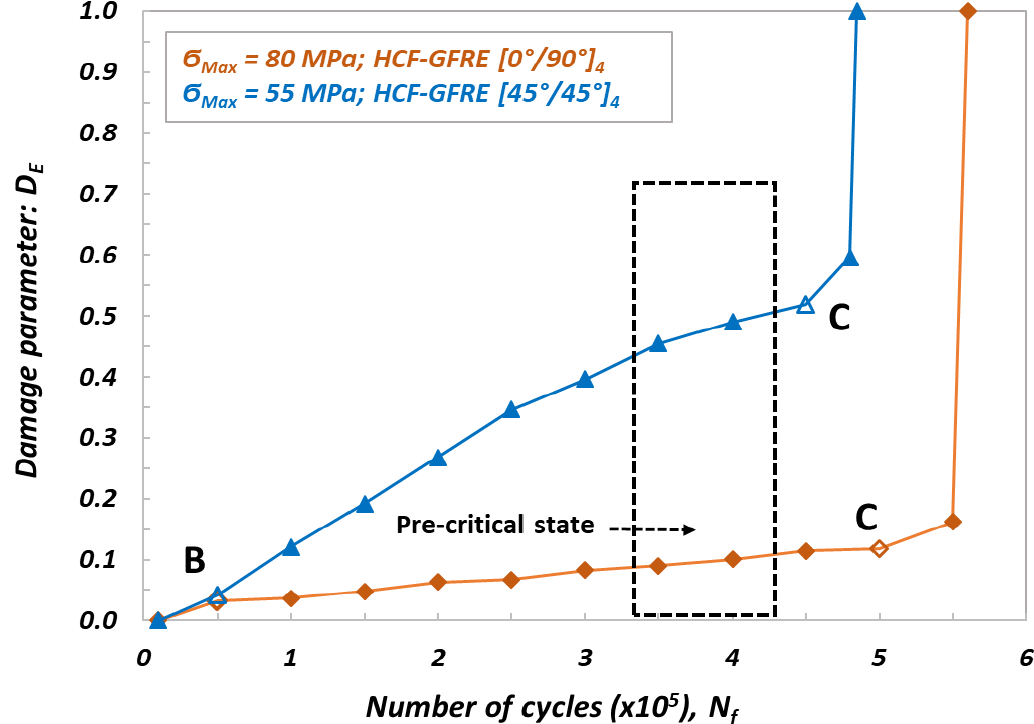
Figure 8. Evolution of damage parameter D E determined from HCF tests loading for GFRE [0°/90°] 4 and GFRE [45°/45°] 4 .